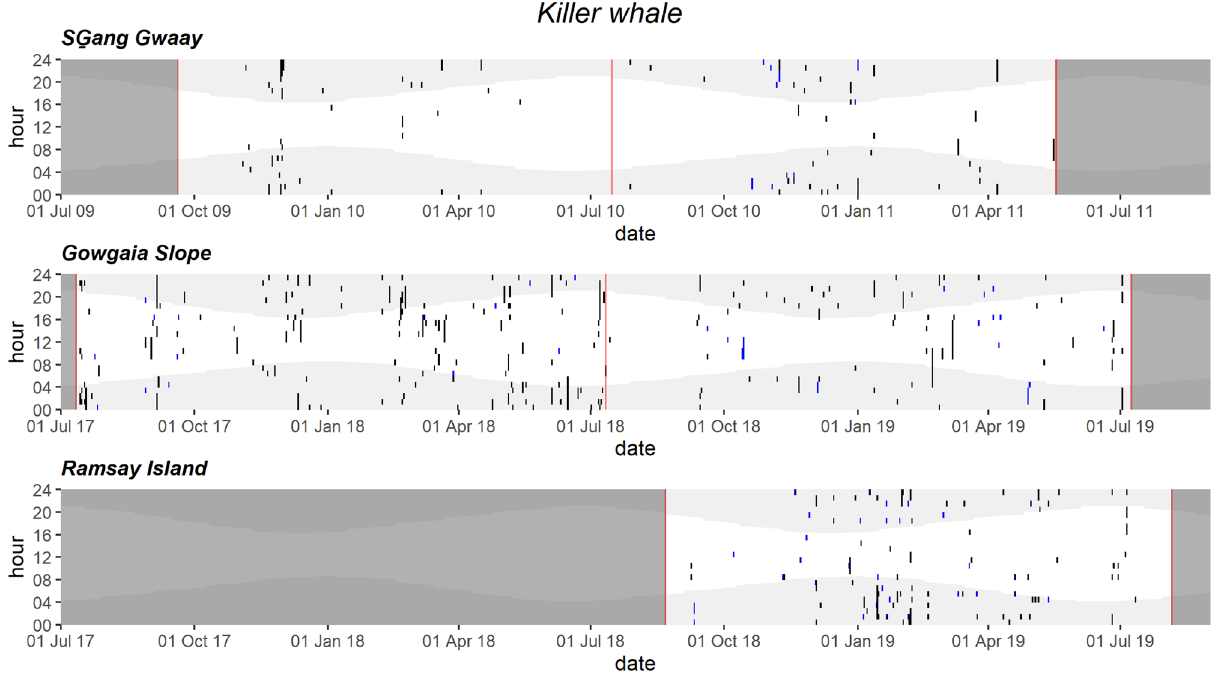
Figure 7. Daily and hourly occurrence of killer whale vocalizations at SG ̱ ang Gwaay, Gowgaia Slope and Ramsay Island in 1-h bins. Blue dots indicate automated detections. Black dots indicate confirmed occurrence. Red lines indicate recorder deployment and retrieval dates. Dark grey areas indicate a lack of recordings. Light grey shaded areas indicate hours of darkness.